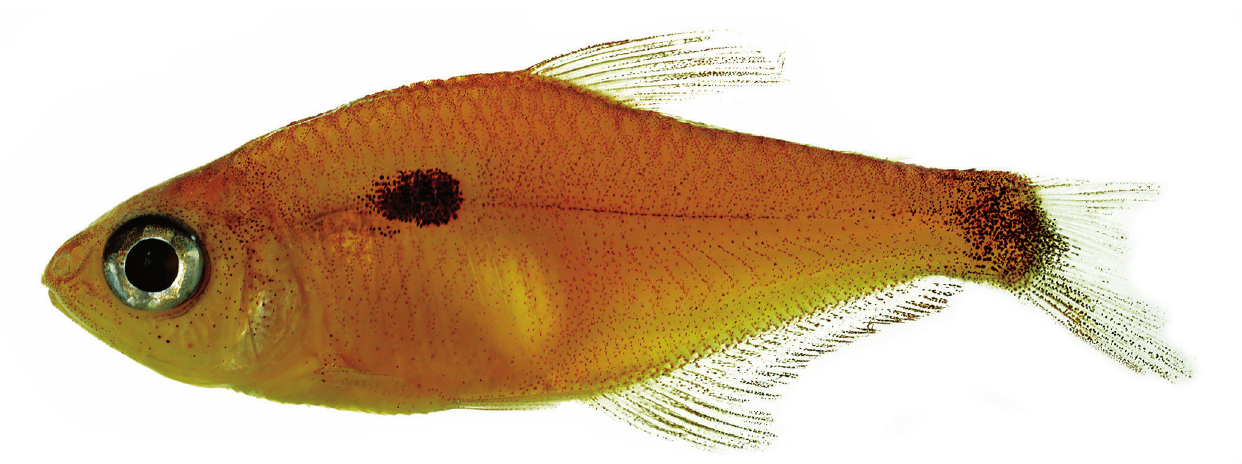
Fig. 2. Phenacogaster julliae , MZUSP 51375, paratype, male, 26.3 mm SL, rio Salitre, Bahia state,